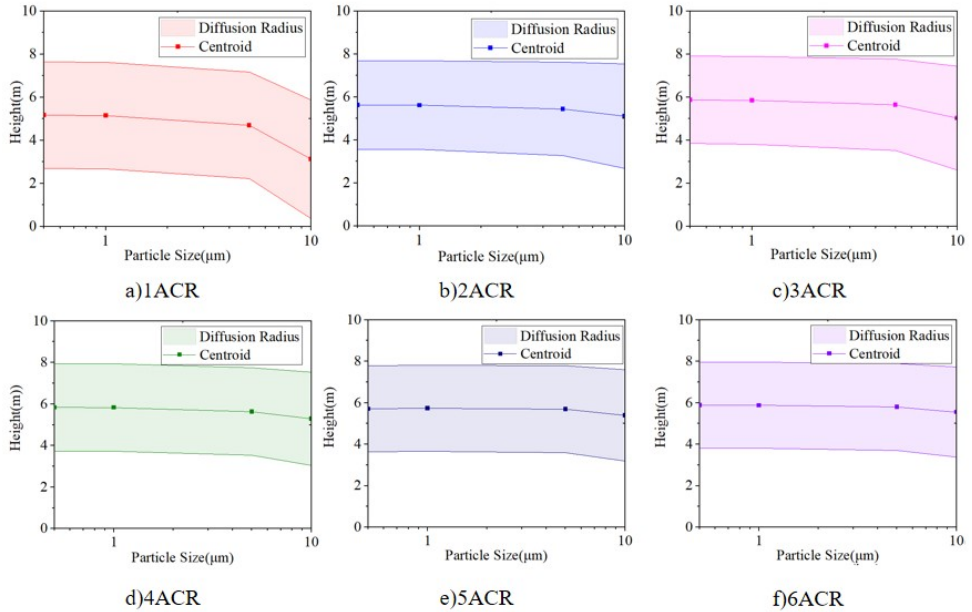
Figure 14. Relationship between centroid height, diffusion radius and stratification height at each air change rate with respect to the particle size: ( a ) ACR = 1, ( b ) ACR = 2, ( c ) ACR = 3, ( d ) ACR = 4, ( e ) ACR = 5, and ( f ) ACR = 6.